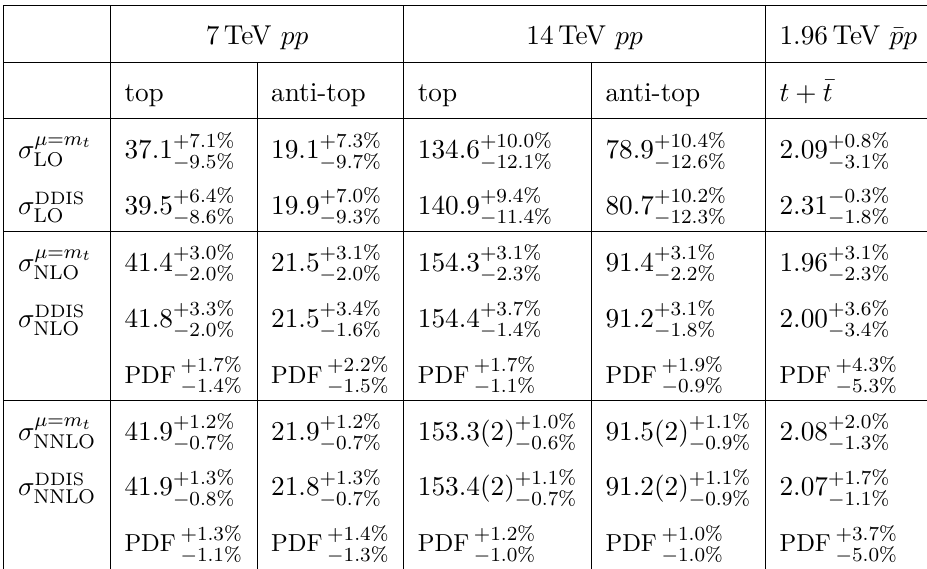
Table 7 . Fully inclusive results in pb for pp at 7 TeV and 14 TeV ( LHC ), as well as p ¯ p at 1 . 96 TeV (Tevatron) with scales µ R = µ F = m t and DDIS scales and using CT14 PDF s. Uncertainties next to the cross section in super- and subscript are from a six-point scale variation, while PDF uncertainties are